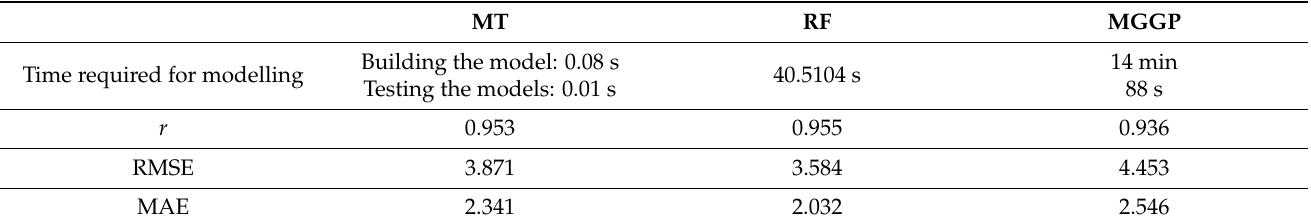
Table 4. Performance indicators of the developed models.